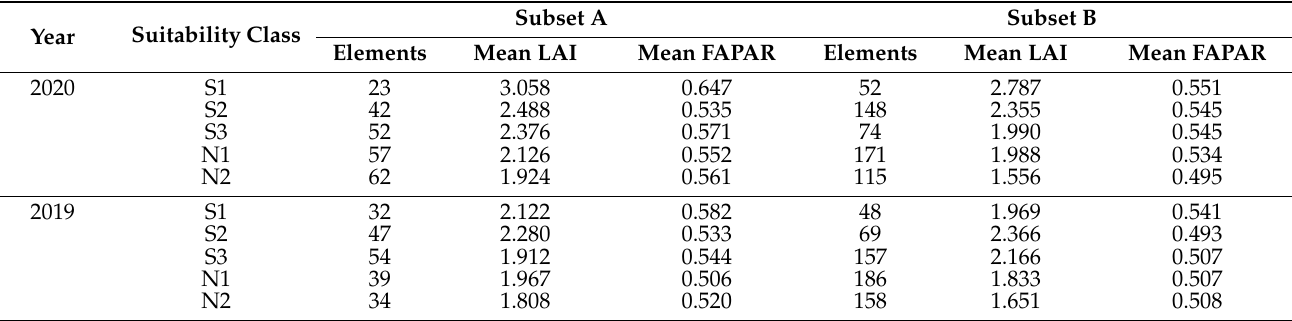
Table A3. Mean LAI and FAPAR values per suitability class after K-means unsupervised classification. Year Suitability